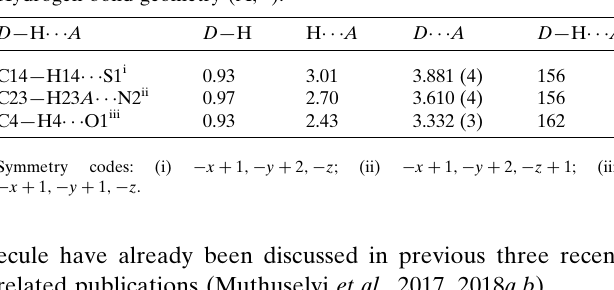
Table 1 Hydrogen-bond geometry (A˚ , (cid:2) ).